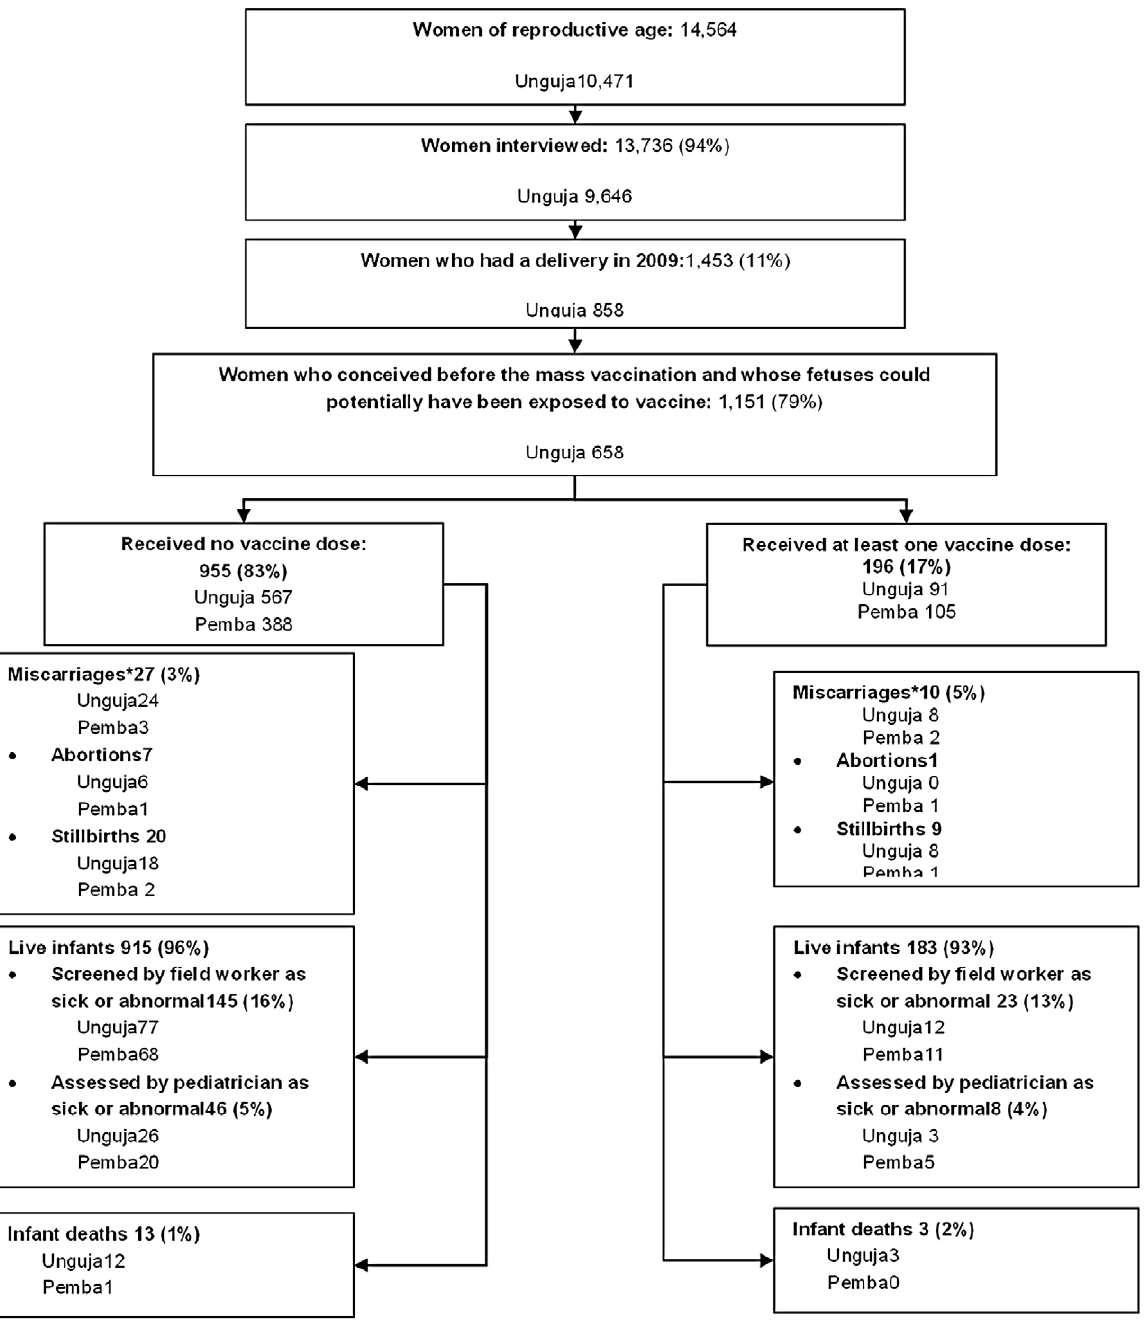
Figure 1. Flow of study participants. *A miscarriage was defined as either an abortion or a stillbirth. An abortion was defined as a termination of a pregnancy within 20 weeks of conception. A stillbirth was defined as a fetus delivered after 20 weeks of gestation without a pulse. doi:10.1371/journal.pntd.0001743.g001 the frequency of adverse birth outcomes between exposed and unexposed pregnancies.